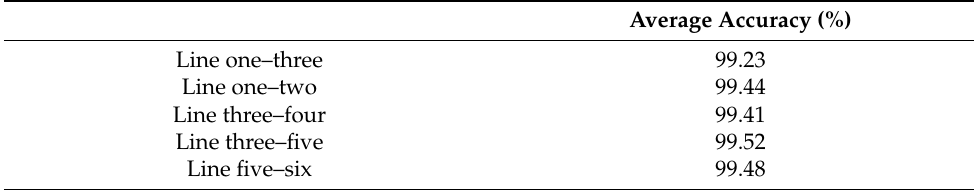
Table 1. The average accuracy of the fault